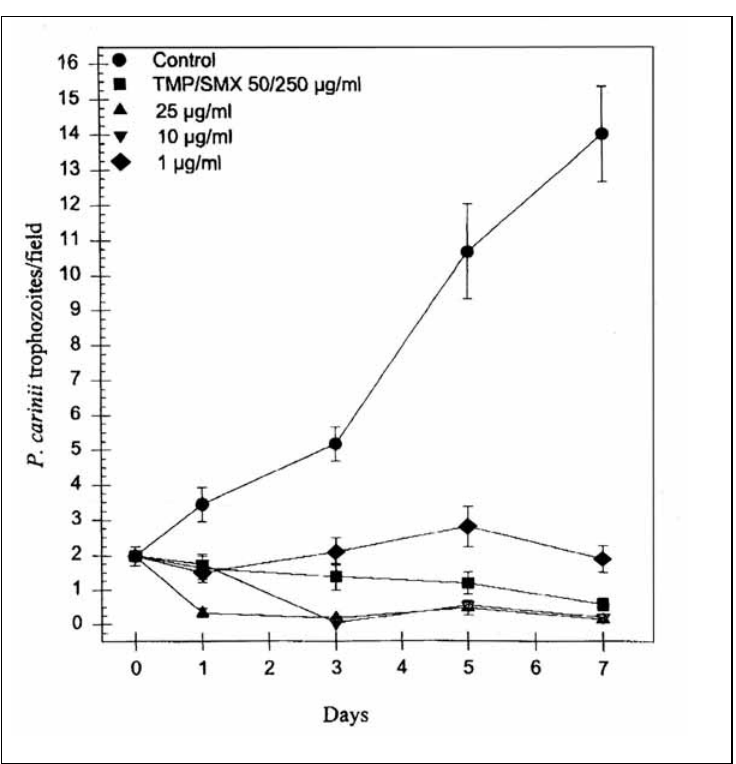
Figure 7. Inhibition of the growth of P. carinii by the antifungal tris(nitronyl nitroxide), 7